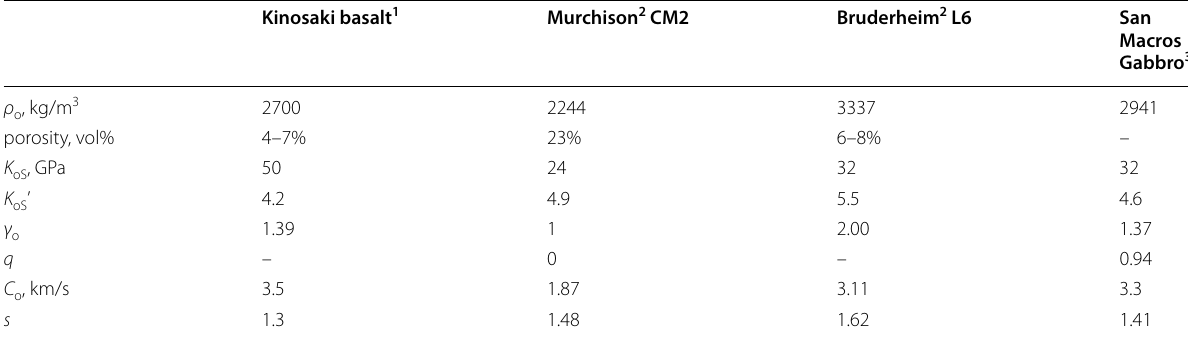
Table 1 Hugoniot data for basalt, gabbro and chondrites